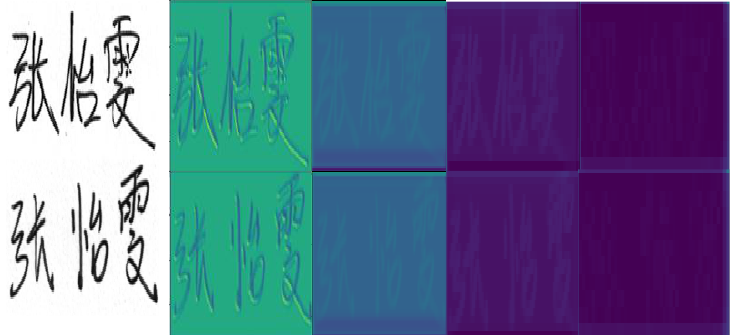
Figure 5. Diagram of the cascaded convolution module.